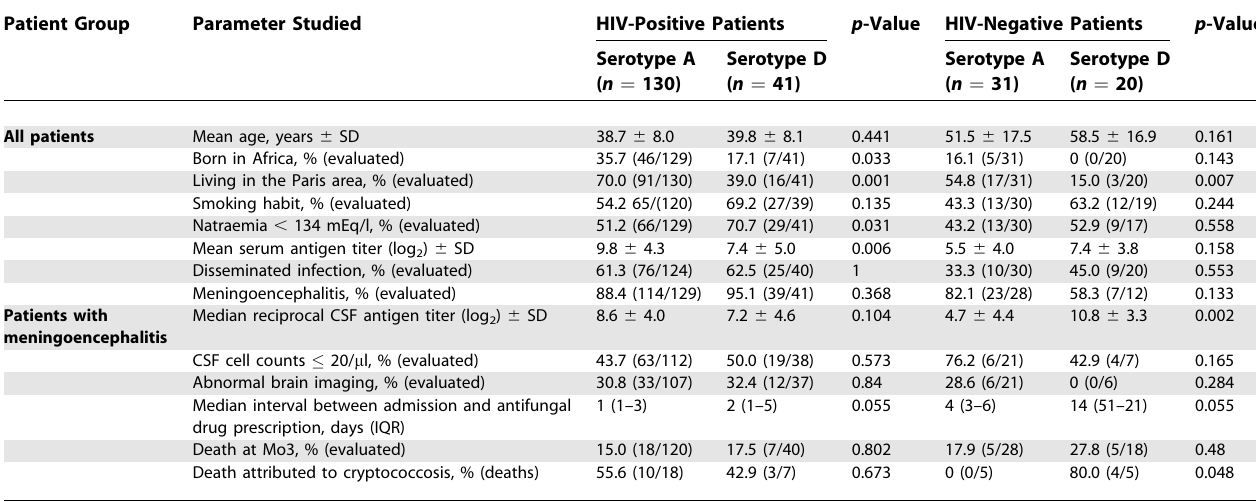
Table 3. Comparisons of Infections Due to C. neoformans Serotype A (var. grubii ) and Serotype D (var. neoformans ) According to HIV